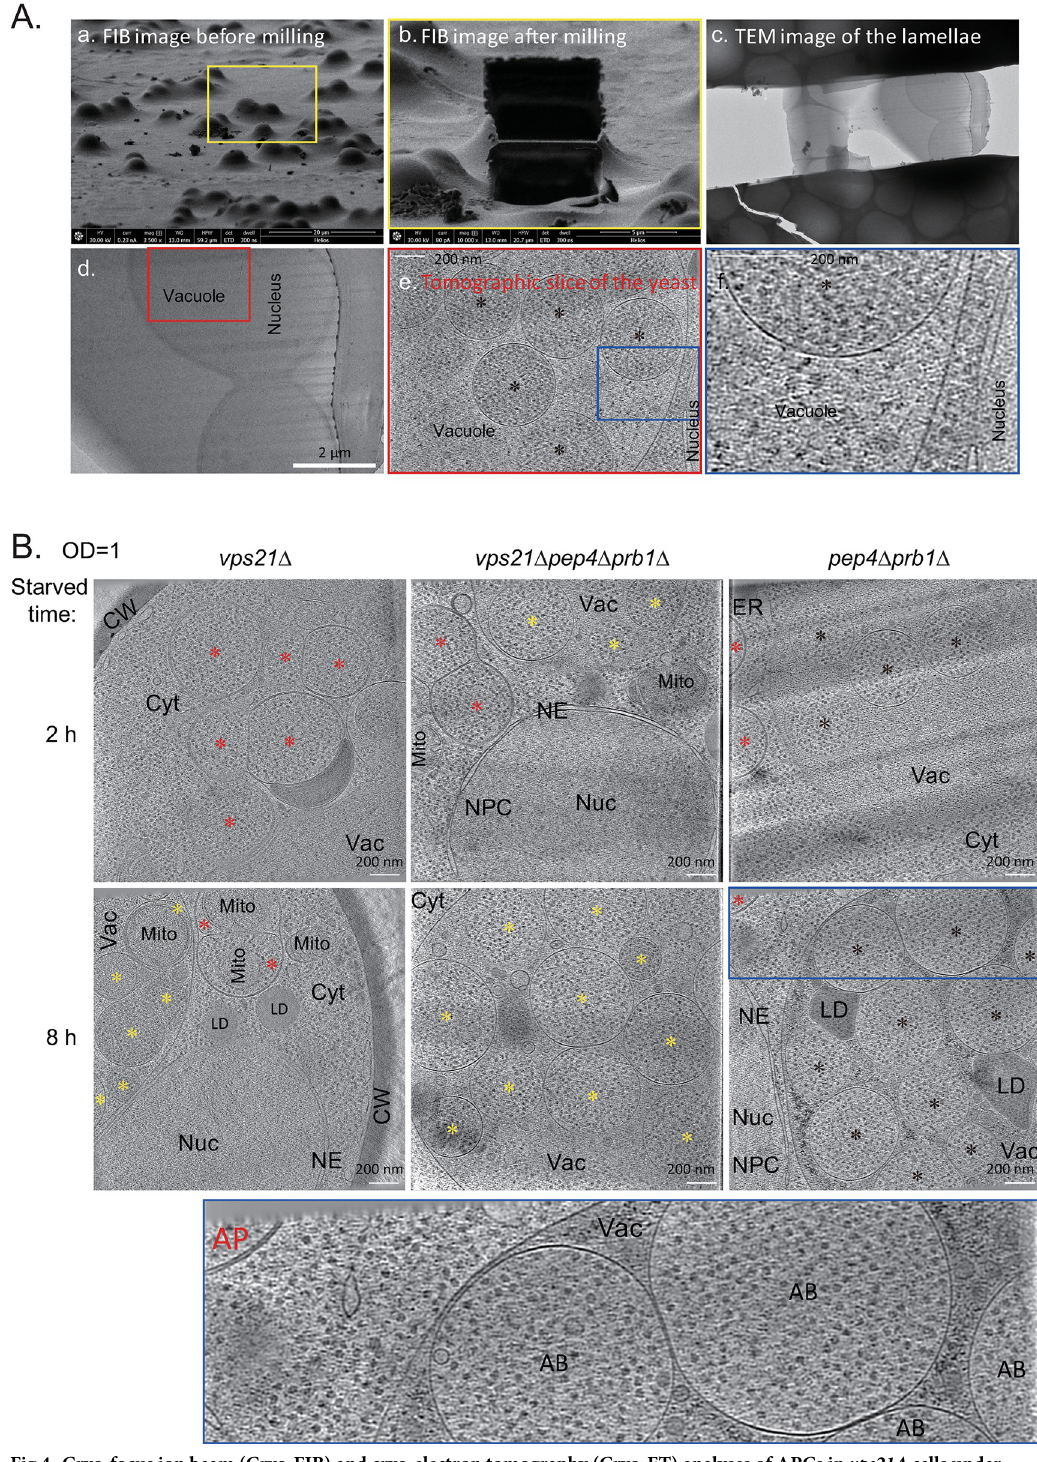
Fig 4. Cryo-focus ion beam (Cryo-FIB) and cryo-electron tomography (Cryo-ET) analyses of APCs in vps21 Δ cells under conditions representative of nitrogen starvation. Cells of vps21 Δ were grown and treated as described in Fig 3A. After subjecting the cells to nitrogen starvation for 2 or 8 h, they were immediately analyzed using the Cryo-FIB and Cryo-ET methods, as described in the Materials and methods section. A. The major steps of Cryo-FIB and Cryo-ET are shown from the left top to the right bottom: a. FIB image before milling; b. FIB image after milling; c. TEM image of the lamellae; d. magnified TEM image;